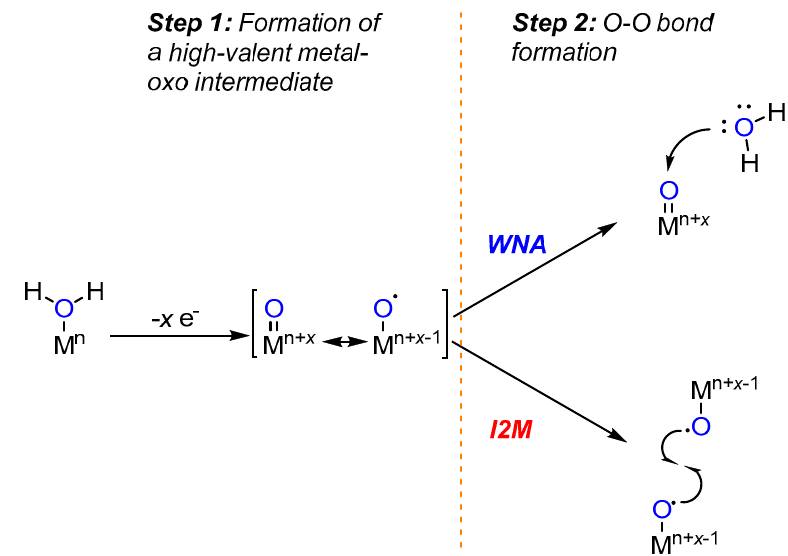
Figure 1. Prevalent mechanistic scenarios for metal catalysed oxidation of water.